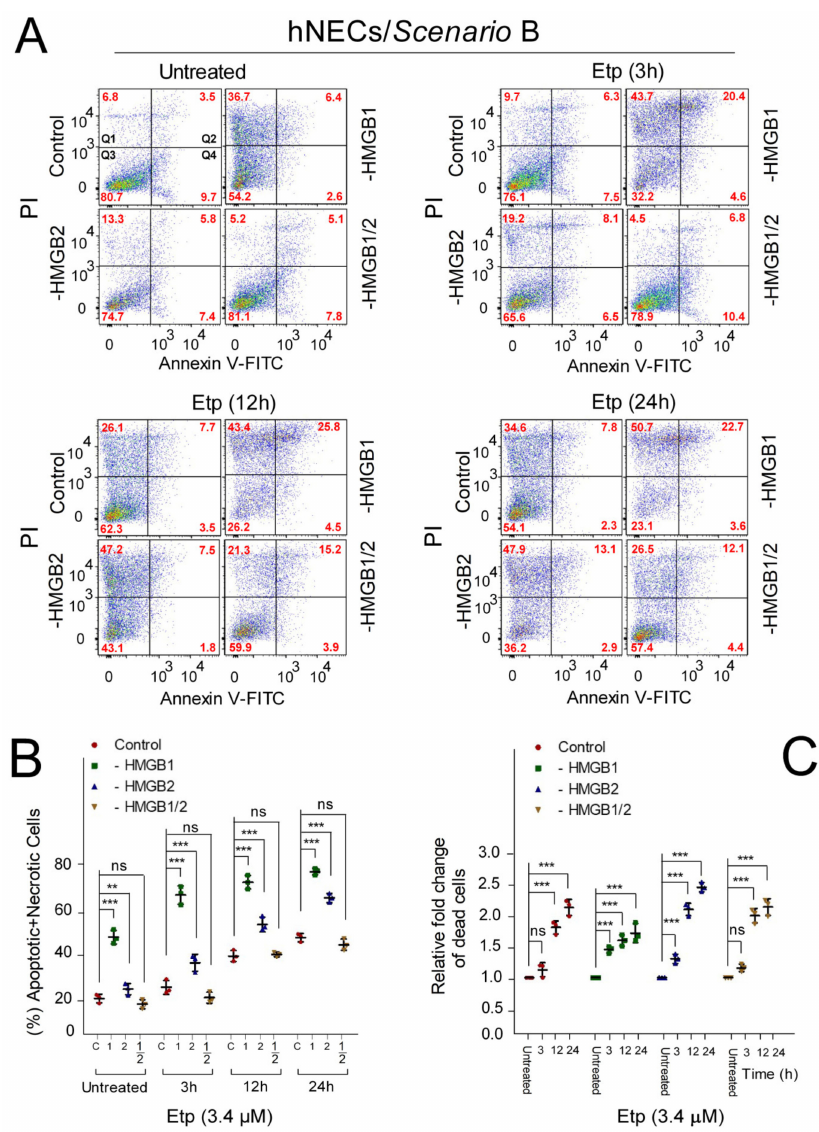
Figure 6. The impact of HMGB1 / 2 KD on apoptosis of etoposide-treated hNECs prepared according to Scenario B. ( A ) Representative dot plots showing Annexin V / propidium iodide (PI) binding assays in hNECs upon HMGB1 and / or HMGB2 KD, followed by etoposide treatment for 0-24 h, as analyzed by flow cytometry. ( B ) Percentage of apoptotic + necrotic cells in hESCs from ( A ). ( C ) Relative fold change of total cell death among populations of control or HMGB KD hNECs compared to untreated cells. Error bars represent the mean and SD of three independent experiments. Data were analyzed using either Bonferroni post hoc test for the (percentage of apoptotic + necrotic cells) or Tukey’s multiple comparison test for analysis of the relative fold change of dead cells ( p > 0.05 = not significant, ns; * p < 0.05; ** p < 0.01; *** p < 0.001). “C”, cells transfected with empty vector; “HMGB1”, cells upon HMGB1 knockdown; “HMGB2”, cells upon HMGB2 knockdown; “HMGB1 / 2”, cells upon HMGB1 and HMGB2 knockdown. “1”, cells upon HMGB1 knockdown; “2”, cells upon HMGB2 knockdown; “1 / 2”, cells upon HMGB1 and HMGB2